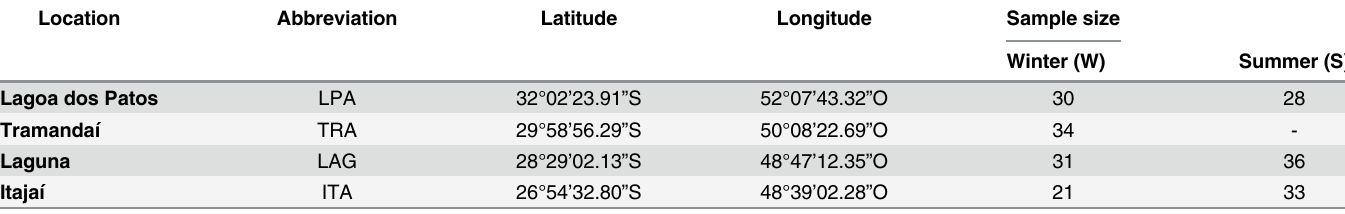
Table 1. Coordinates and sample sizes of study areas in winter 2013 and summer